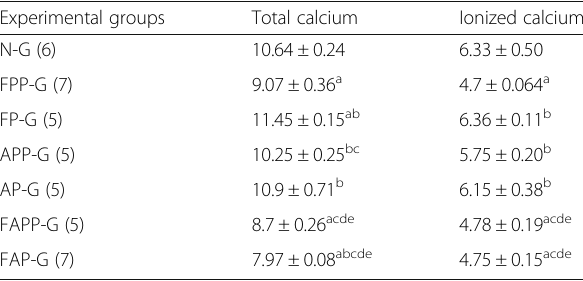
Table 4 Levels of the total and ionized calcium (g/dl) in the serum of offspring rats exposed to NaF or AlCl 3 alone and in combination through the pre- or/and postnatal stages